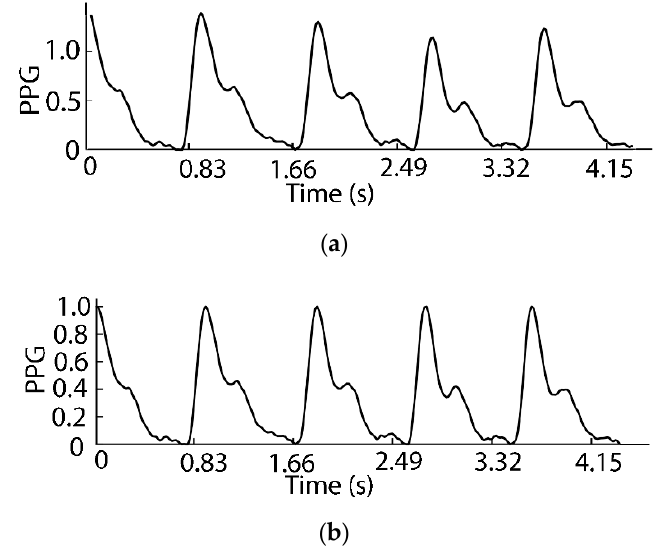
Figure 10. ( a ) PPG signal after base line correction; ( b ) PPG signal after peak line correction. (7) Peak line correction : This correction is performed when pulse wave peaks are found in